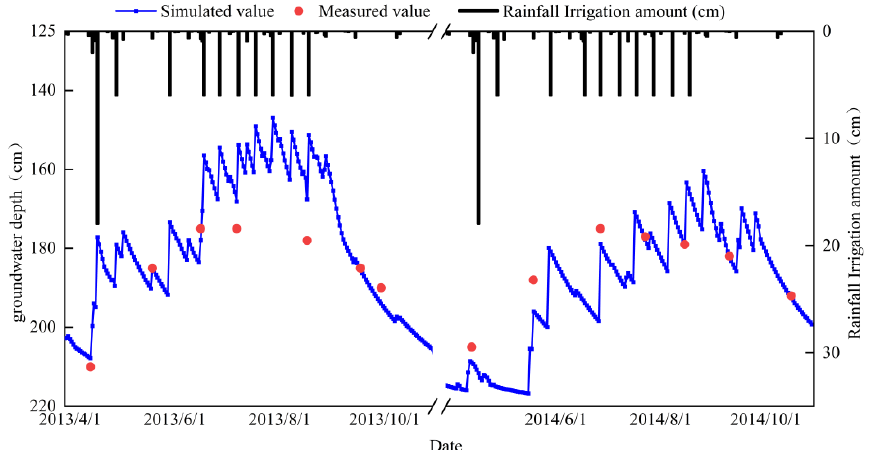
Figure 3. Calibration of the hydrological changes in the soil of the study area.